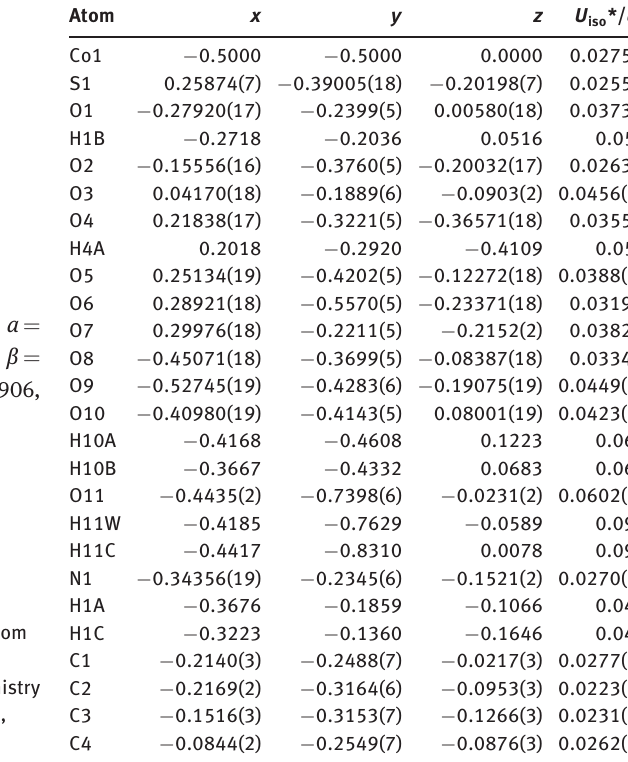
Table 2: Fractional atomic coordinates and isotropic or equivalent isotropic displacement parameters (Å 2